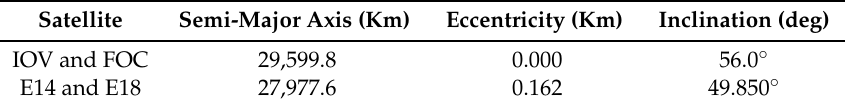
Table 1. Galileo satellite nominal orbit